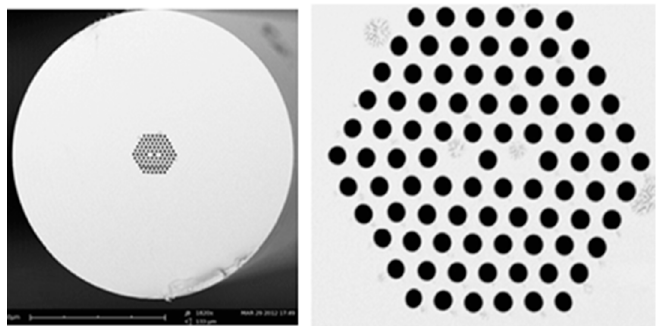
Figure 17. Schematic diagram of the experimental setup and SEM image of the hollow core PCF and sensing probe (Reproduced from [70], with the permission of OSA publishing).